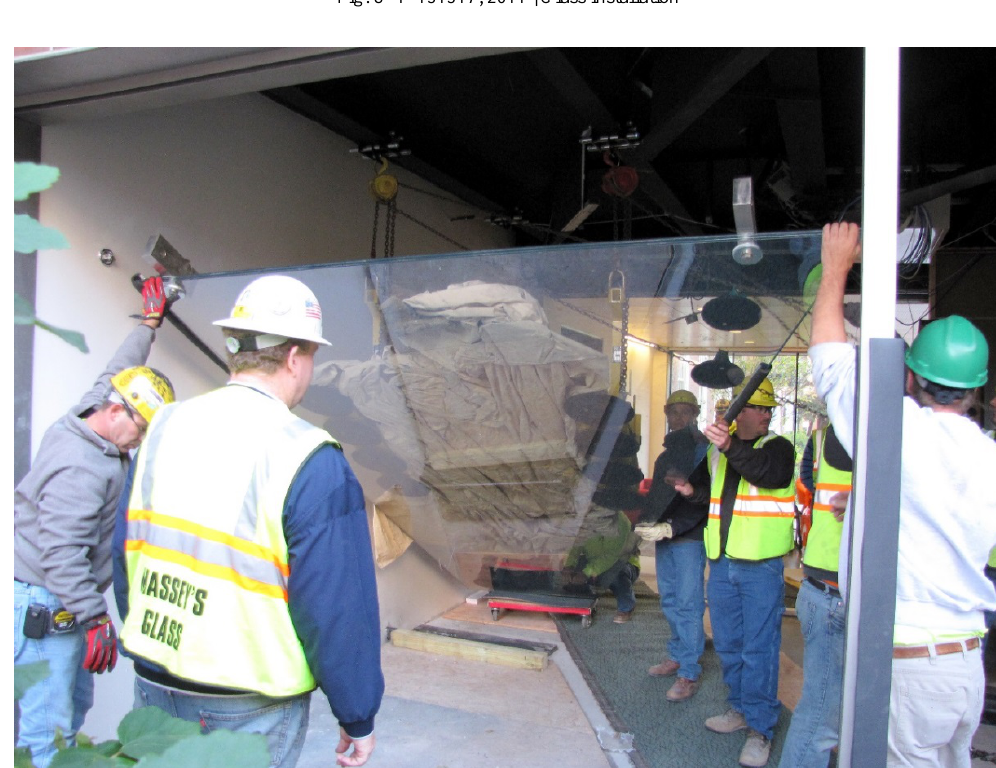
Fig. 8 P-131317, 2011 | Glass installation